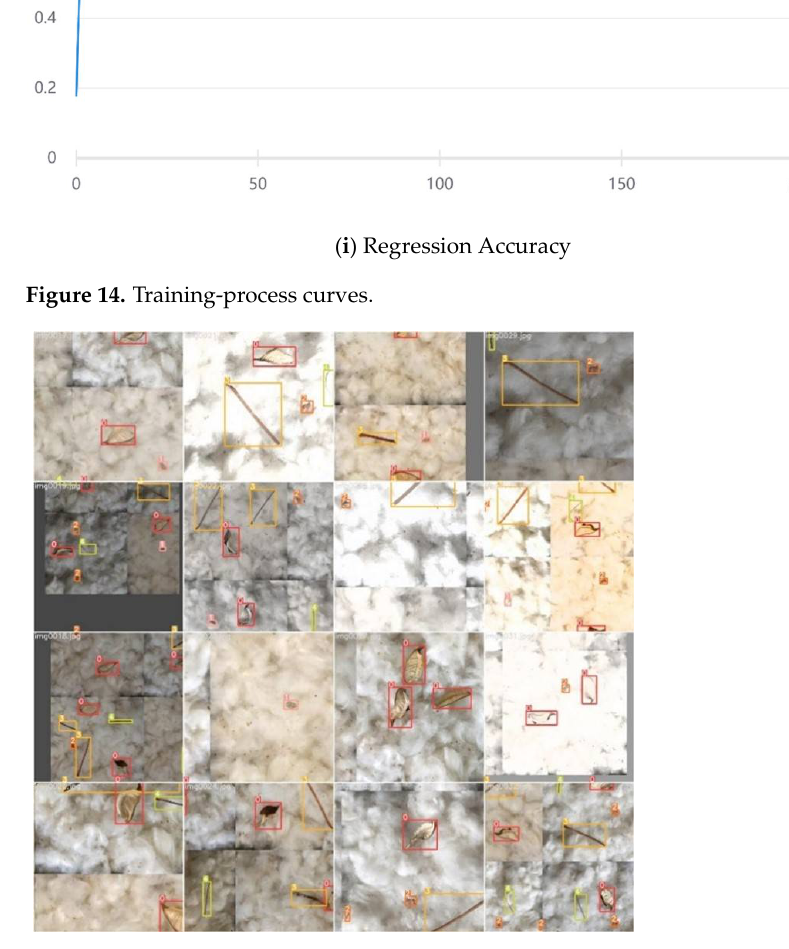
Figure 15. Test picture used in training process.